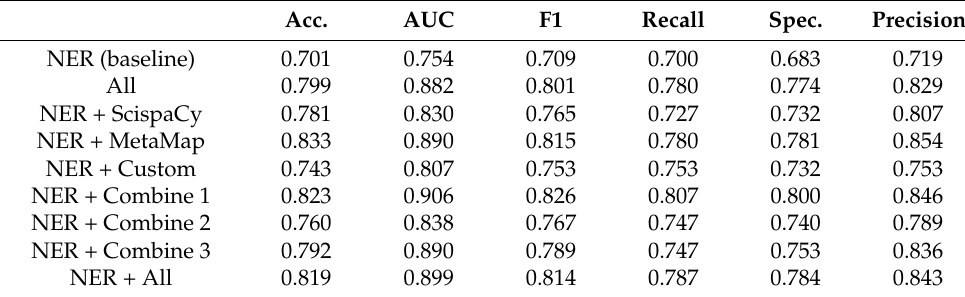
Table 7. Performance of NER and BioIE-based prediction. Acc. Recall Spec.